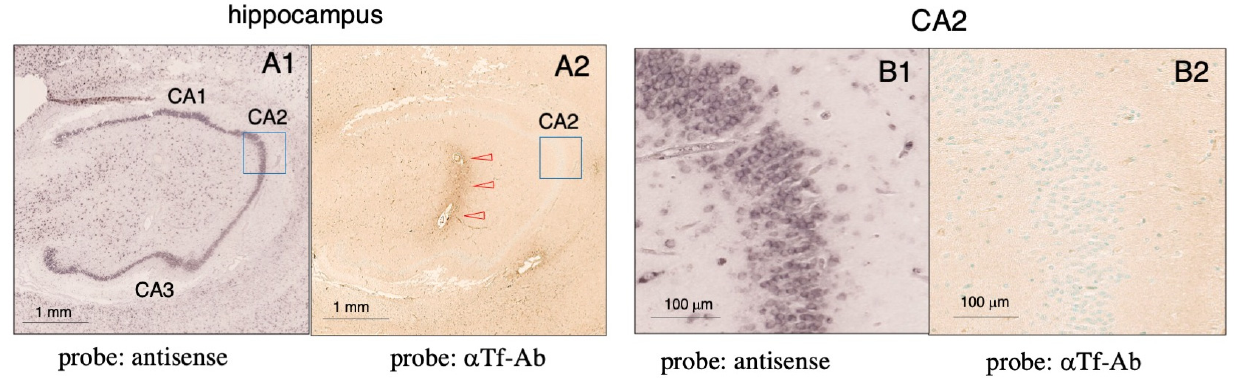
Figure 8. In situ hybridization and immunohistochemistry of human hippocampal tissue. Pairs of mirror ‐ image sections of human hippocampus were prepared: one was subjected to in situ hybridization ( A1 ), and the other was stained with anti ‐ human Tf antibody and methyl green ( A2 ). Immunostaining revealed diffuse signals surrounding blood vessels ( A2 , red arrowheads). In high magnifications of mirror ‐ image sections, positive antisense signals are seen in the CA2 region ( B1 )